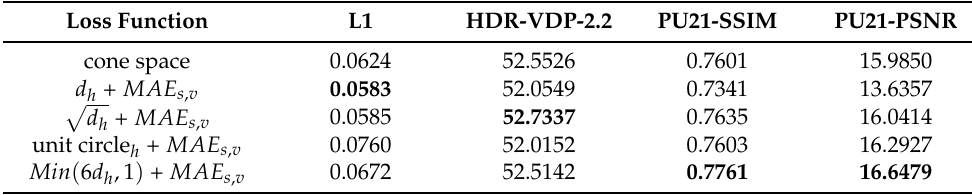
Table 4. The test results for different loss functions: The same mask parameters are applied ( s (cid:48) = 1.0, c = 1.0, v min = 0.7). The values in bold indicate the best scores for each metric. Loss Function L1 HDR-VDP-2.2 PU21-SSIM PU21-PSNR cone space 0.0624 52.5526 0.7601 15.9850 d h + MAE s , v 0.0583 52.0549 0.7341 0.0585 unit circle h + MAE s , v